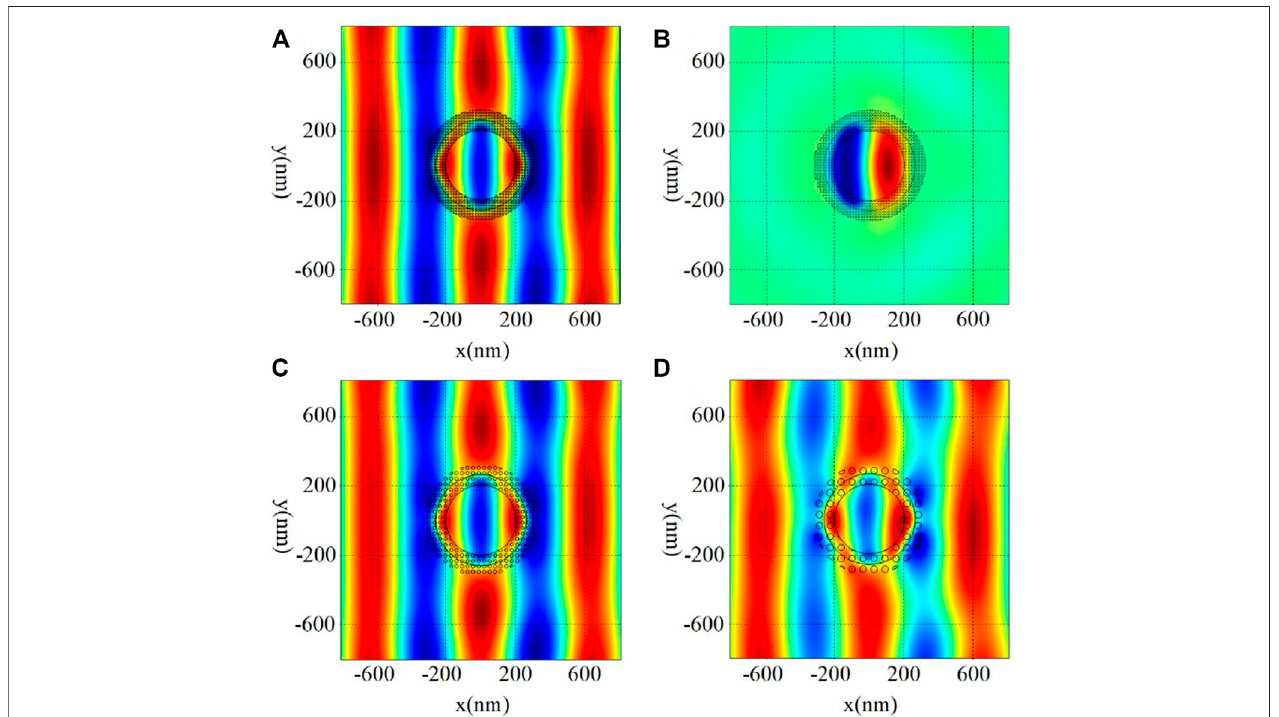
FIGURE4| (Coloronline) (A,C – D) Theelectric fi eldexcitedbythe632.8 nmplaneopticalwaveforthecloakconstructedbythesubwavelength structureswithcell dimension of 16 nm (A) , 32 nm (C) and 63 nm (D) . (B) The scattering fi eld from the nanoprobe which is under the protecting of the coating layers constructed by the subwavelength structures with cell dimension of 16